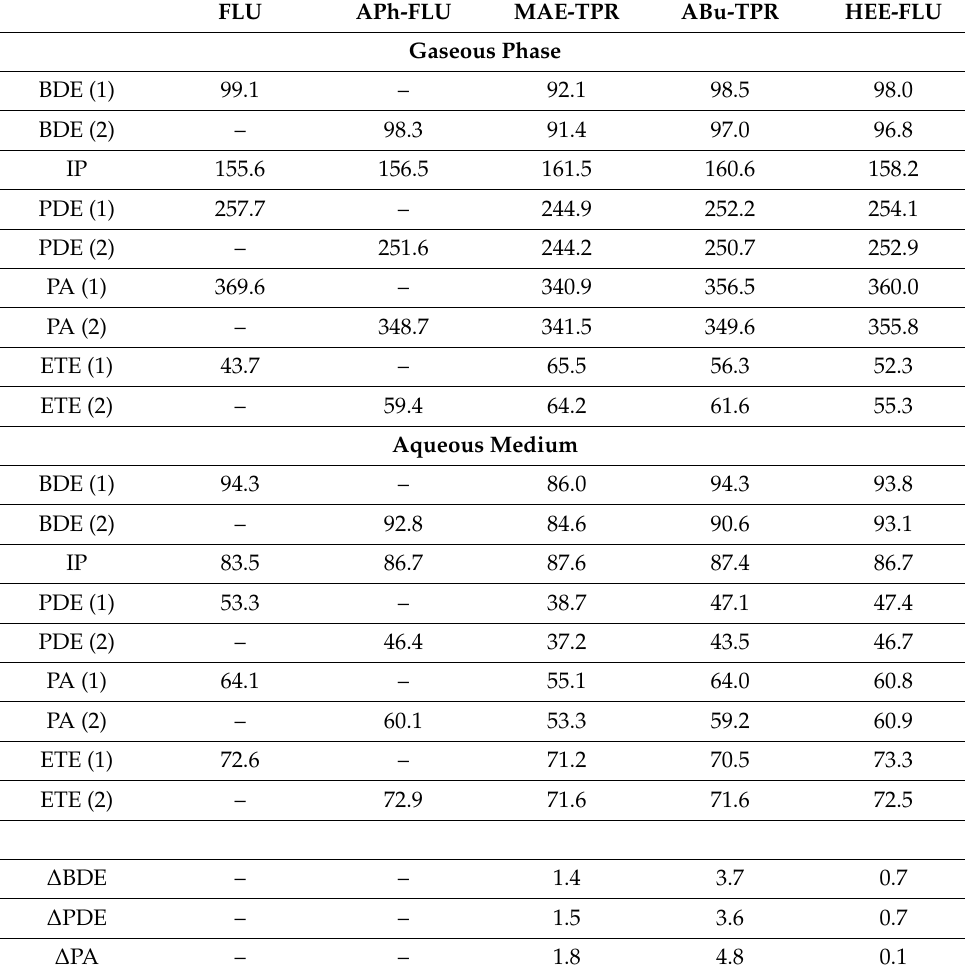
Table 1. The values (kcal × mol − 1 ) of the thermochemical parameters in the gaseous phase and in the aqueous medium for the hydroxyl groups located in the side chain of the investigated TFMP derivatives (the digit in parentheses identifies the given hydroxyl group in a molecule). The values (kcal × mol − 1 ) of ∆ BDE, ∆ PDE, and ∆ PA were calculated in the aqueous medium. FLU APh-FLU MAE-TPR ABu-TPR HEE-FLU